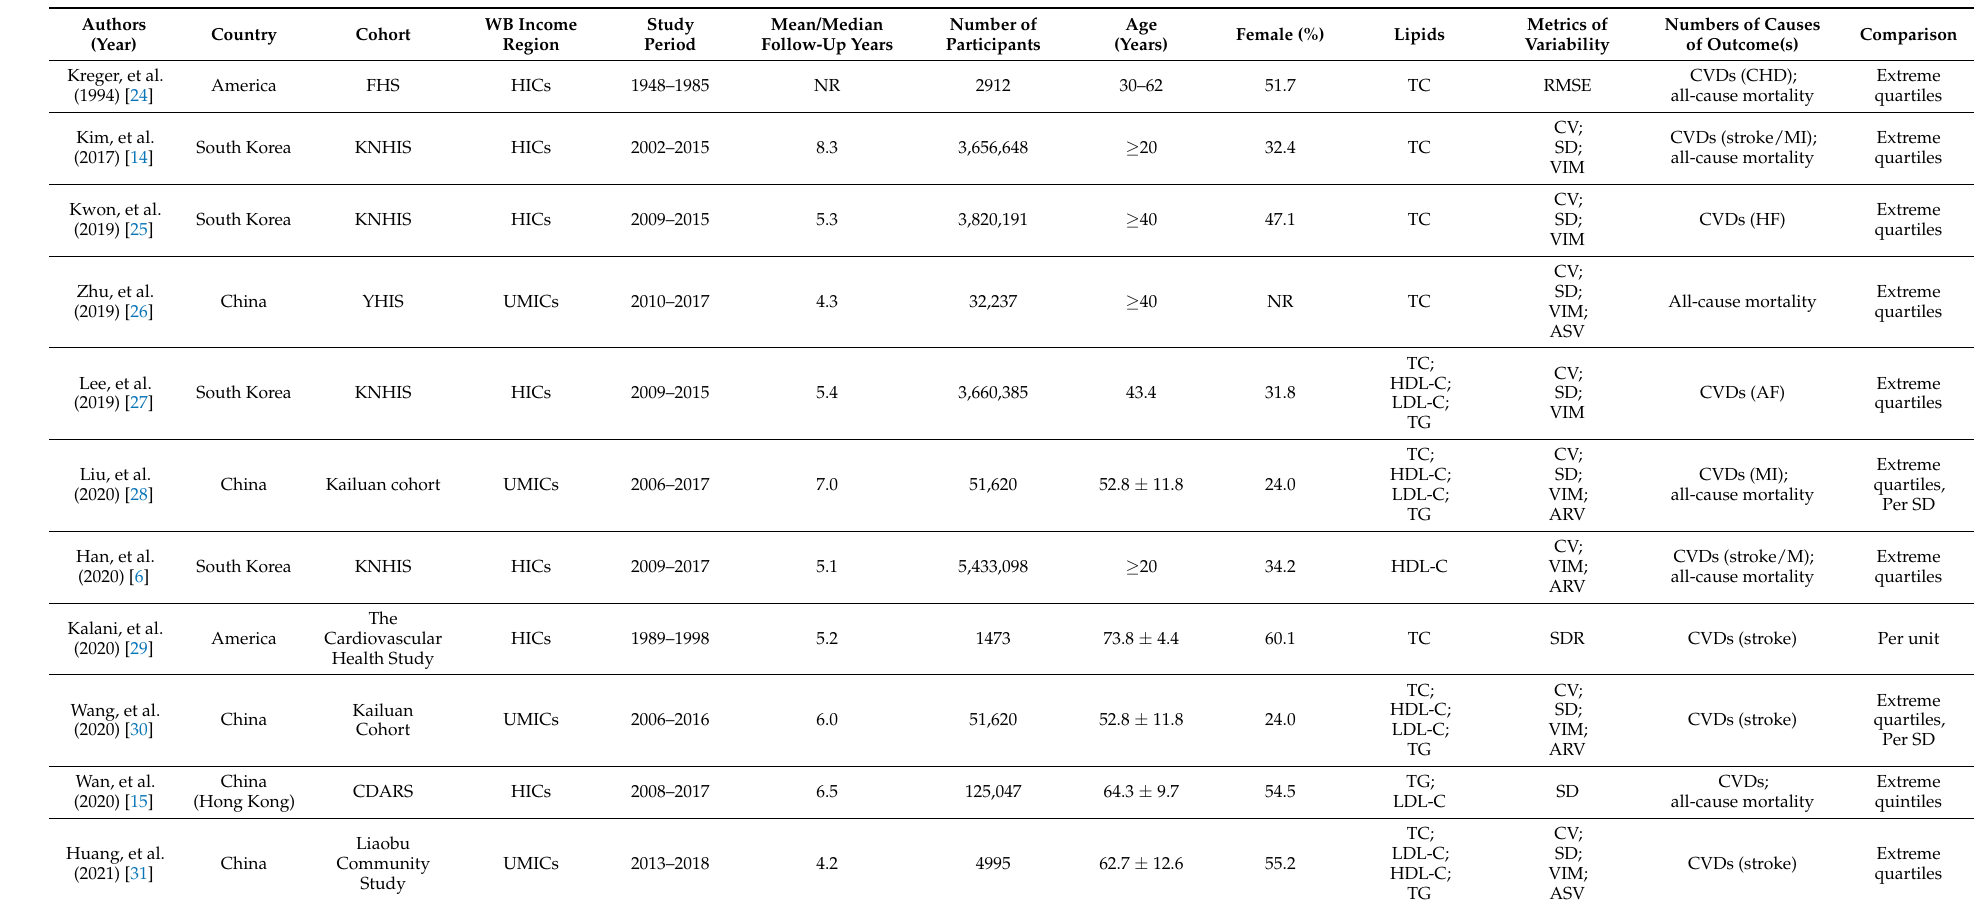
Table 1. Detailed characteristics of the included articles ( n =